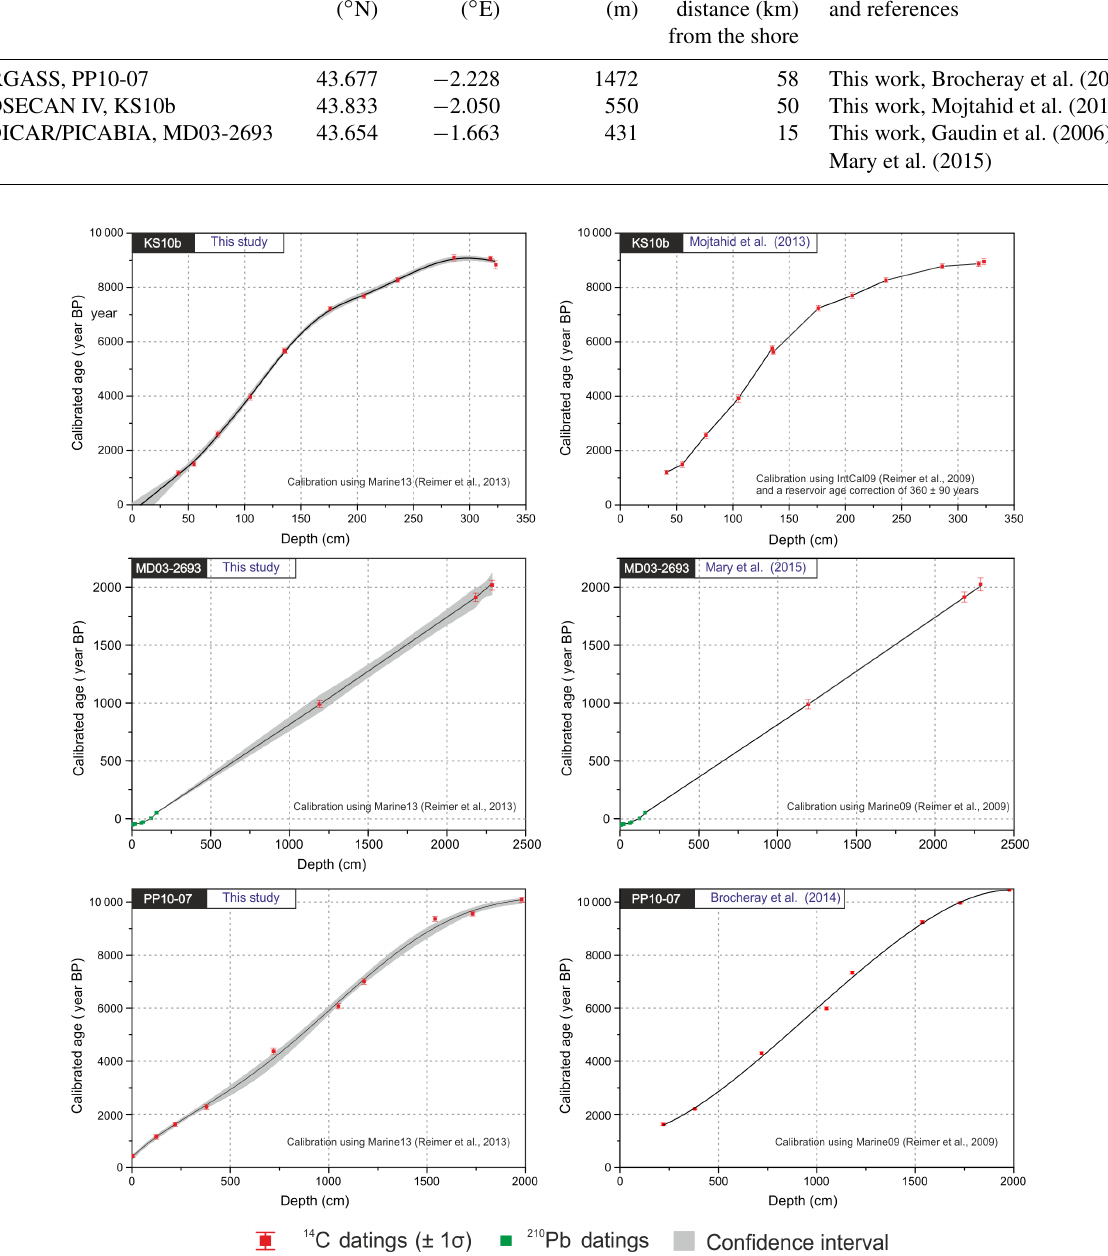
Figure 2. Revised age models for cores KS10b, MD03-2693 and PP10-07 (left panels) compared to previous published age models (right panels with original